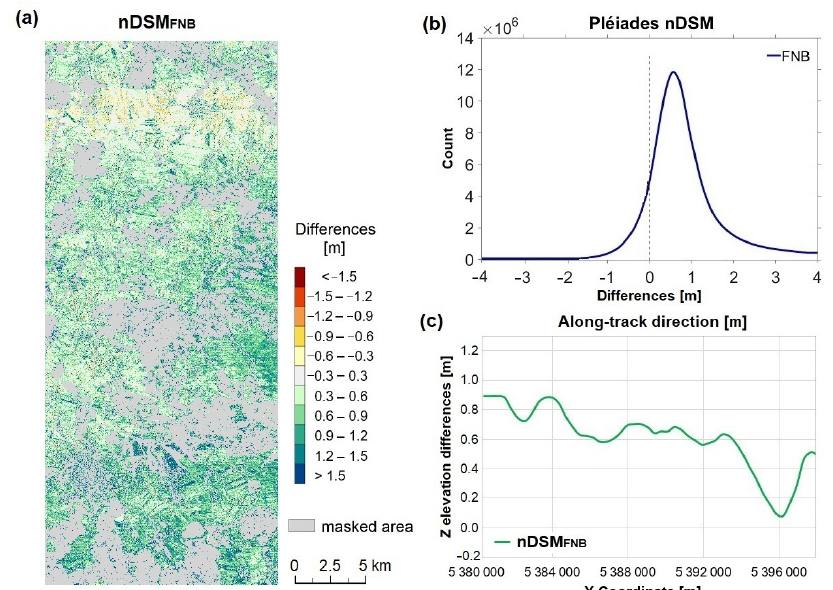
Figure 7. Differences between Pléiades DSM FNB and Lidar reference DTM in open areas: ( a ) Color- coded height differences (masked areas are shown in grey). ( b ) Frequency distribution of height discrepancies. ( c ) Section profile in along-track direction with Z elevation differences.